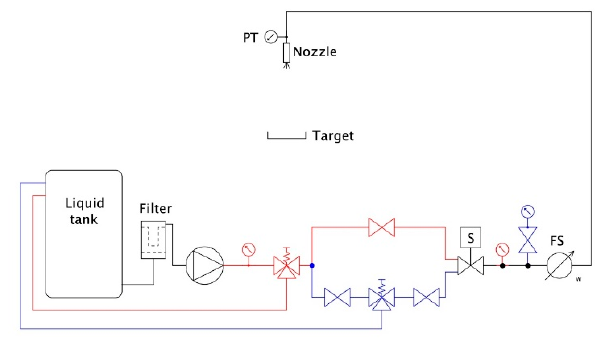
Figure 1. Scheme of the hydraulic circuit (blue: low pressure line; red: high pressure line; S: electro valve; FS: flux sensor; PT: pressure transmitter).